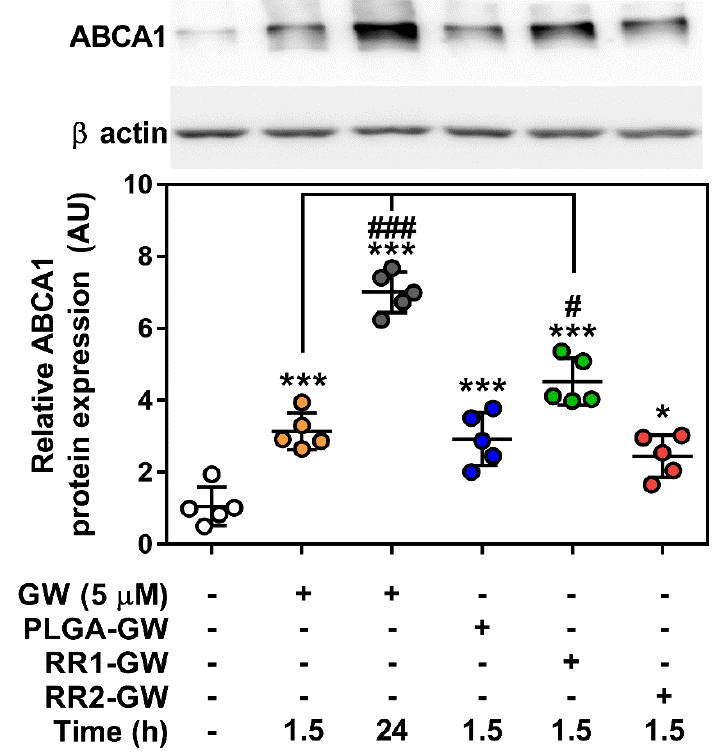
Figure 5. ABCA1 protein expression is upregulated with RR1-GW nanoparticle treatment. WT BMDM were treated with nanoparticles encapsulating 5 µM GW-3965 for 1.5 h. ABCA1 protein was measured 24 h post-treatment and normalized to ß actin. Data represent mean ± SEM where *** p < 0.001 and * p < 0.05 are differences compared with vehicle control, while ### p < 0.001 and # p < 0.05 is compared to acute GW-3965 dose determined by one-way ANOVA ( n = 5).